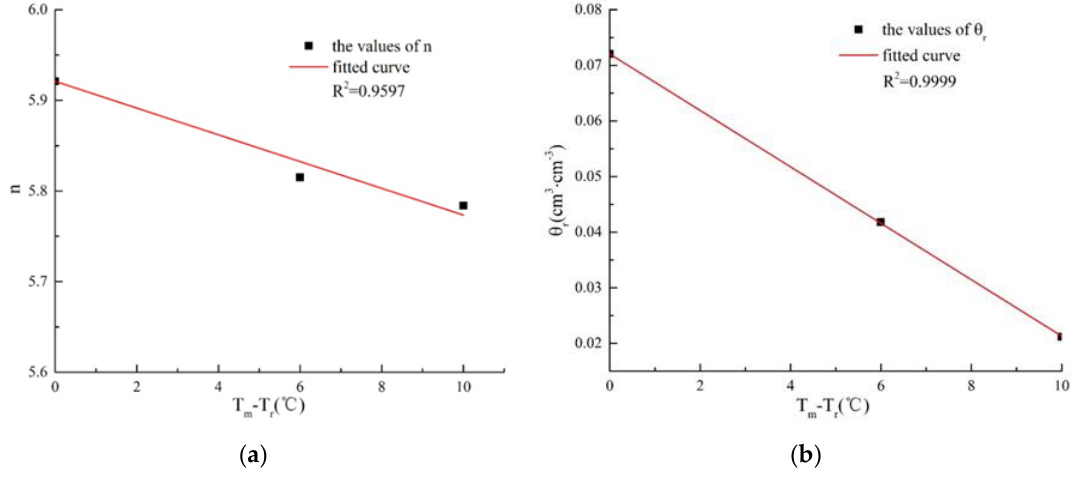
Figure 7. Fitting values for parameters n and θ r . ( a ) shows the change of n with temperature, and ( b ) shows the change of θ r with temperature.